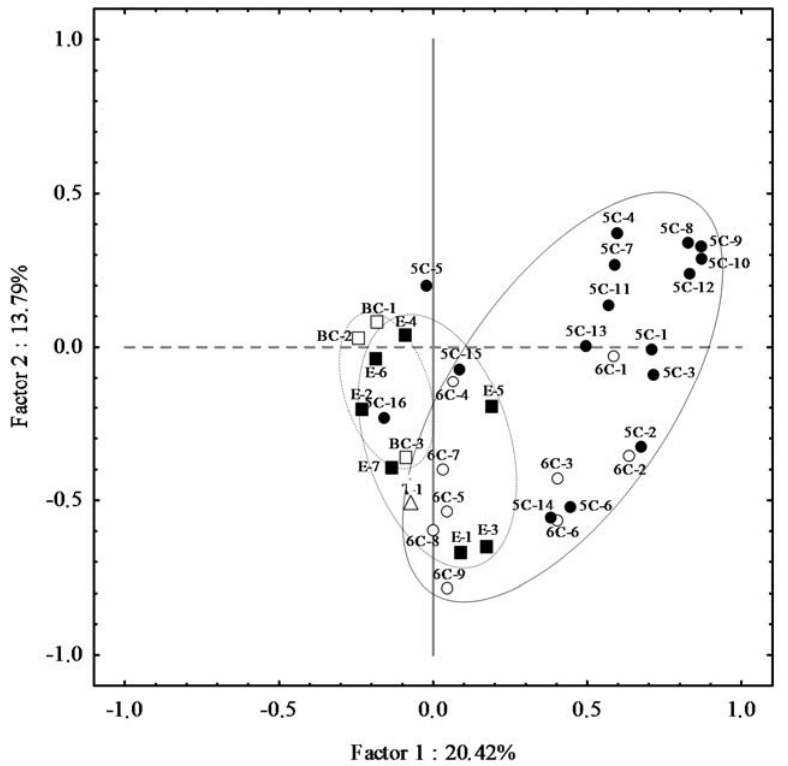
Figure 2. Vector distribution of the main volatile compounds in the oils of the Core ‐ 36